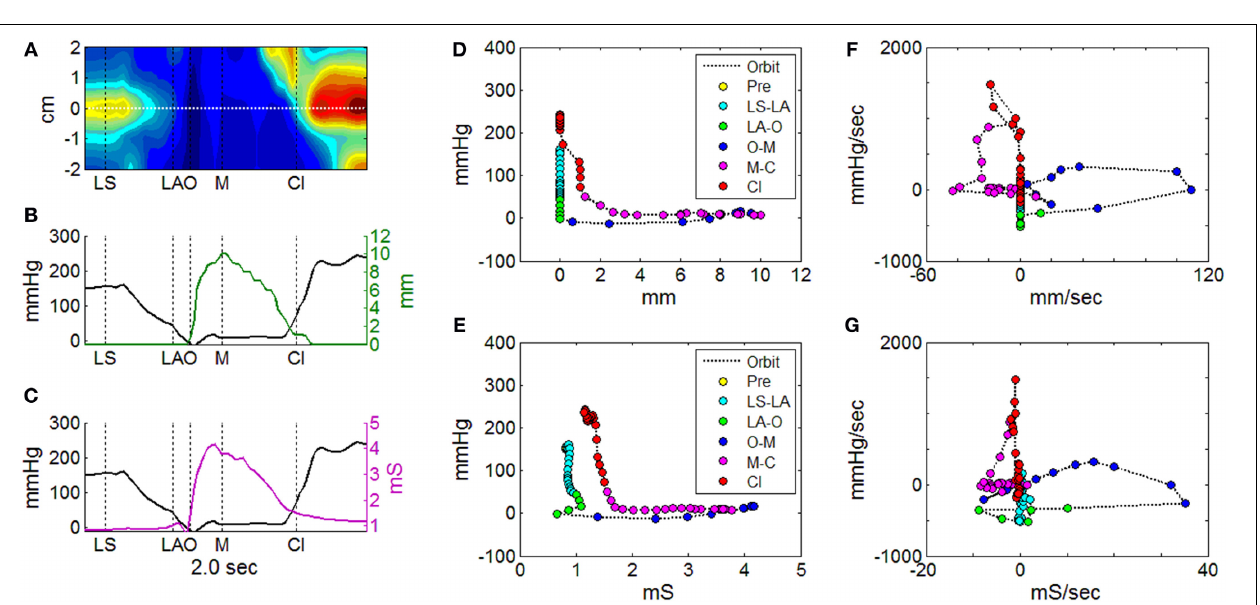
diameter (based on fluoroscopy) at the reference segment. (C) Plot of pressure (at position 0cm in A ) and admittance at the reference segment. (D) Orbit plot based on diameter vs. pressure data over time in (B) , with samples color coded for order of time sequence. (E) Orbit plot based on admittance vs. pressure data over time in (C) , with samples color coded for order of time sequence. (F) Time derivative orbit plot of diameter vs. pressure with samples color coded for time sequence. (G) Time derivative orbit plot of admittance vs. pressure with samples color coded for time